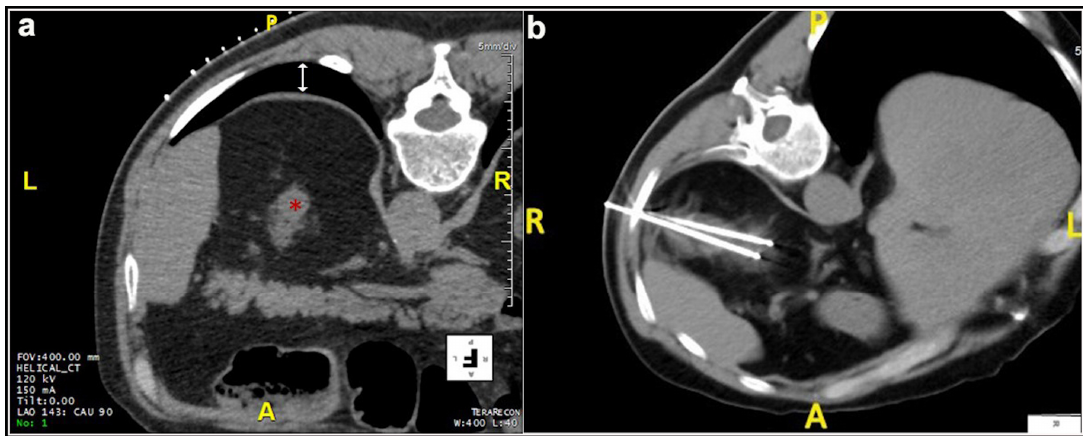
Figure 1. Male, 73 years old. ( a ) Preparation of the treatment of a lesion located at the upper pole of the left kidney ( * ). The initial scan shows the interposition of the costophrenic sinus (white arrow). ( b ) The patient was positioned in an oblique decubitus, on the same side of the costophrenic sinus, to free the path for the two cryoprobes and the lesion was adequately treated without pneumothorax.